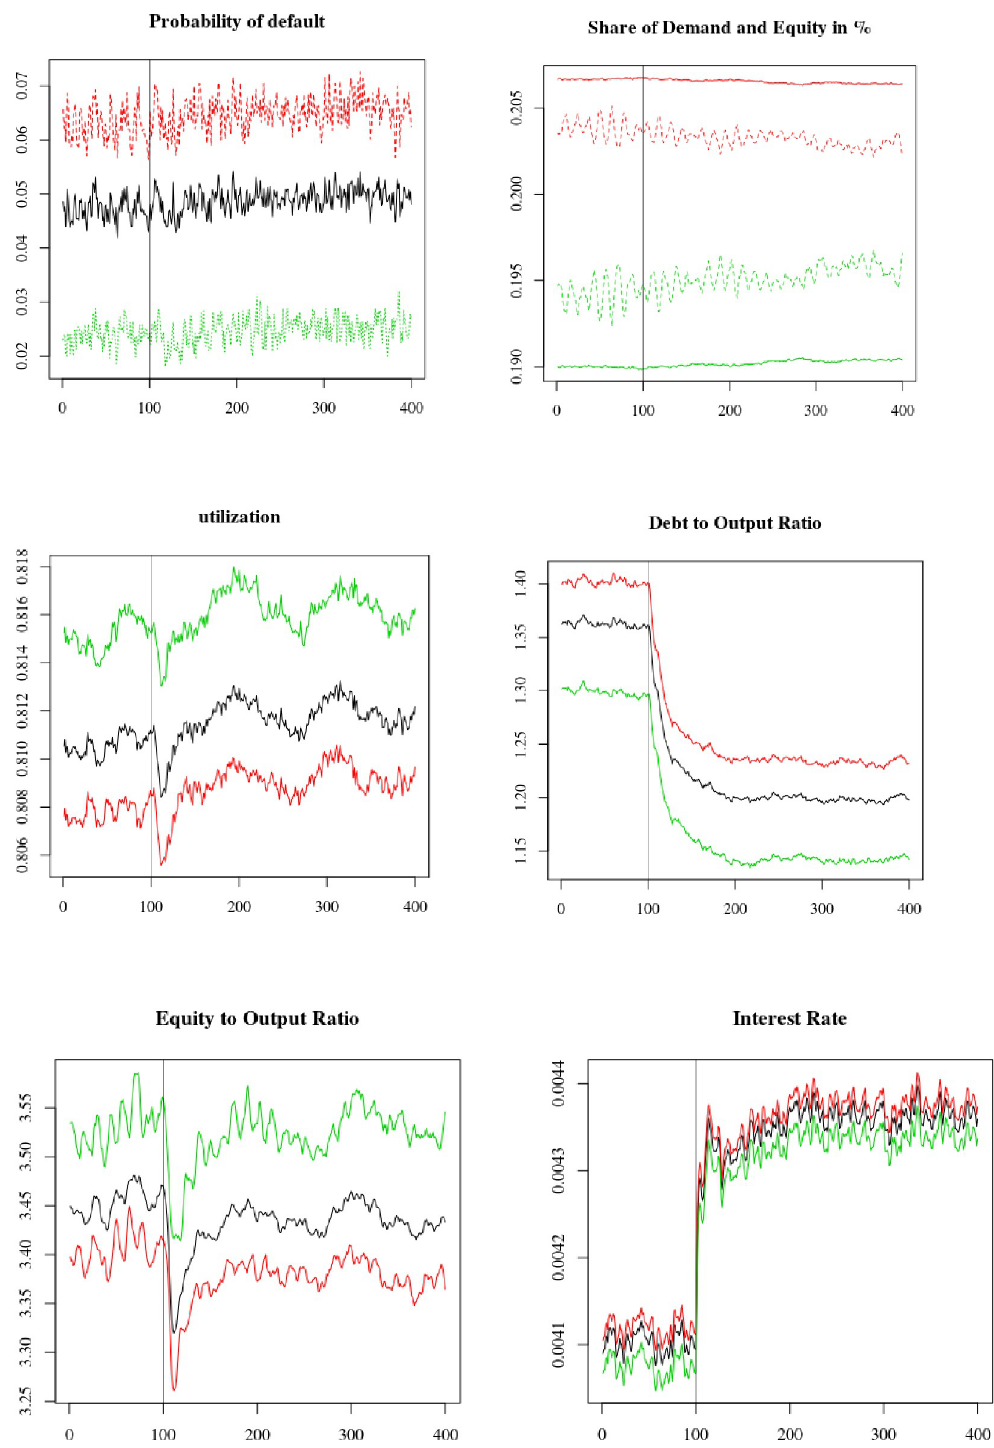
Fig 8. Monetary policy tightening: Increase in the parameter i cb at t = 600. Average firms (black), overconfident firms (red) and neutral firms (green).